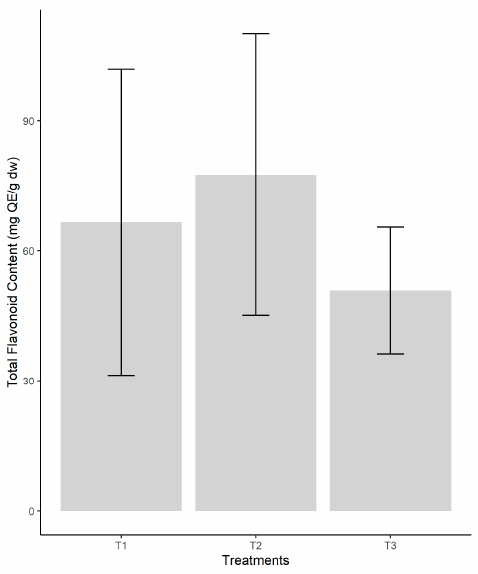
Figure 5. Comparison of the total flavonoid content, according to the type of substrate used in the cultivation of P. ostreatus . Legend: T1—pine sawdust; T2—coconut coir; T—waste paper .